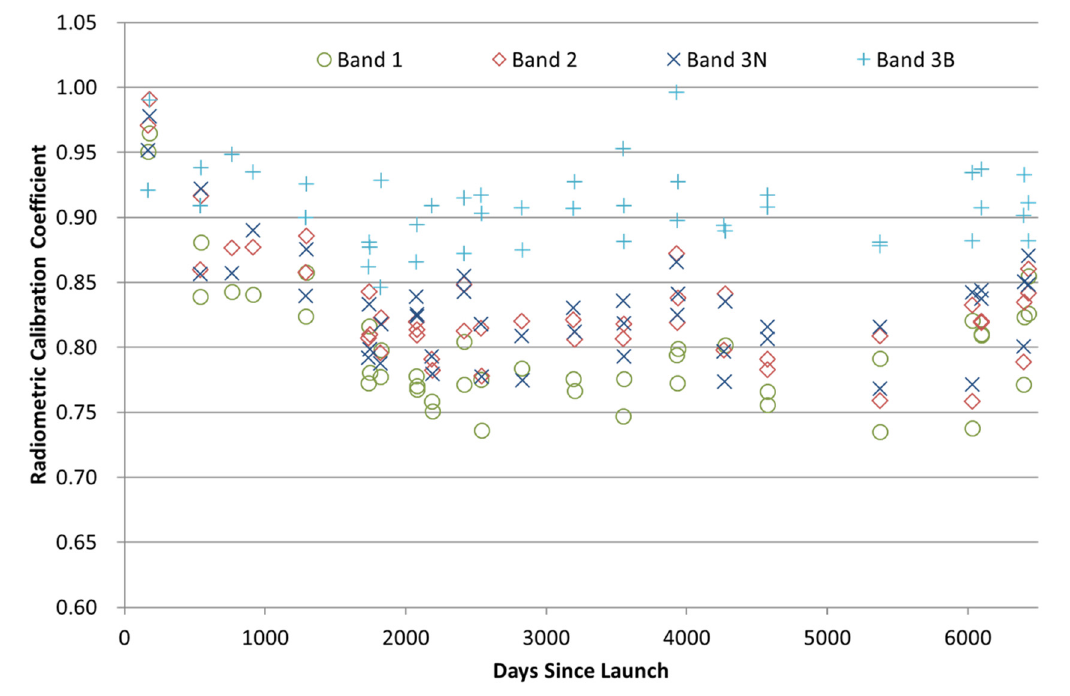
Figure 1. Radiometric calibration coefficients (RCCs) derived from the vicarious calibration of the reflectance-based method carried out from 2000 to 2017.